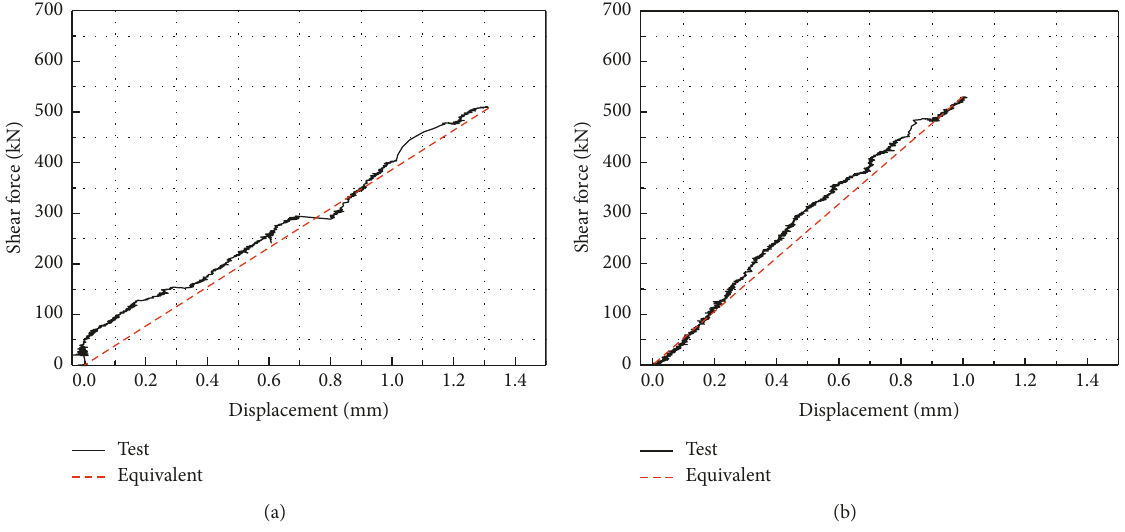
Figure 12: Initial shear test results. (a) Left limiting block. (b) Right limiting block.